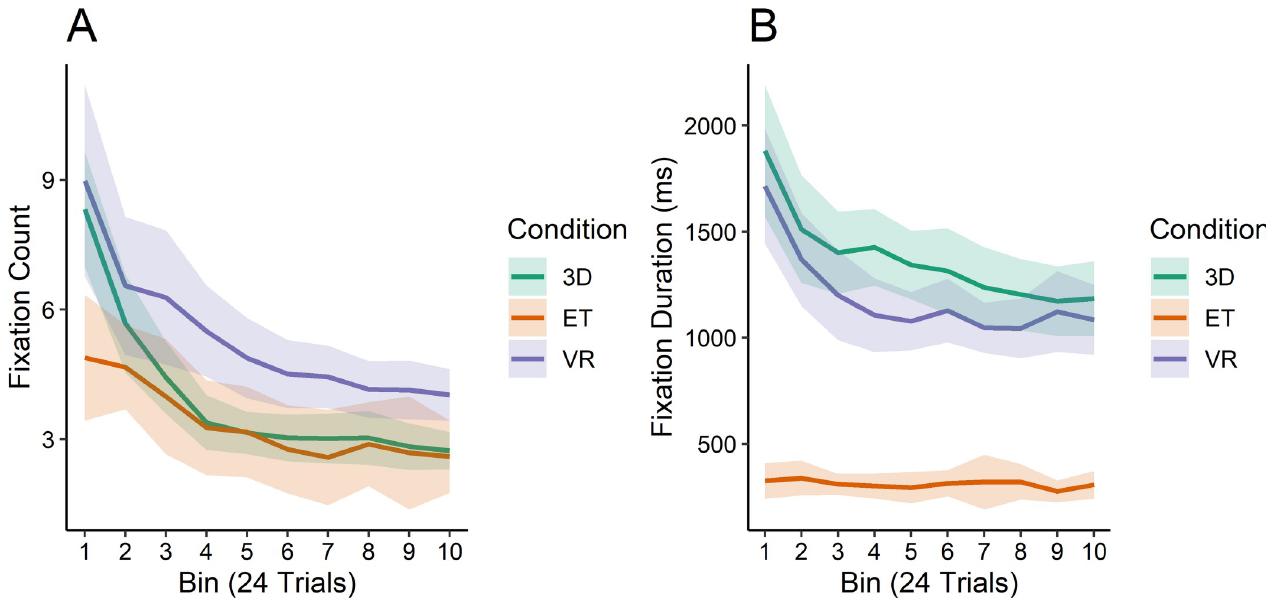
Fig 8. Fixation counts and average fixation durations. (A) Number of fixations per trial averaged for each bin, by condition. (B) Average fixation length in milliseconds for each bin, by condition.